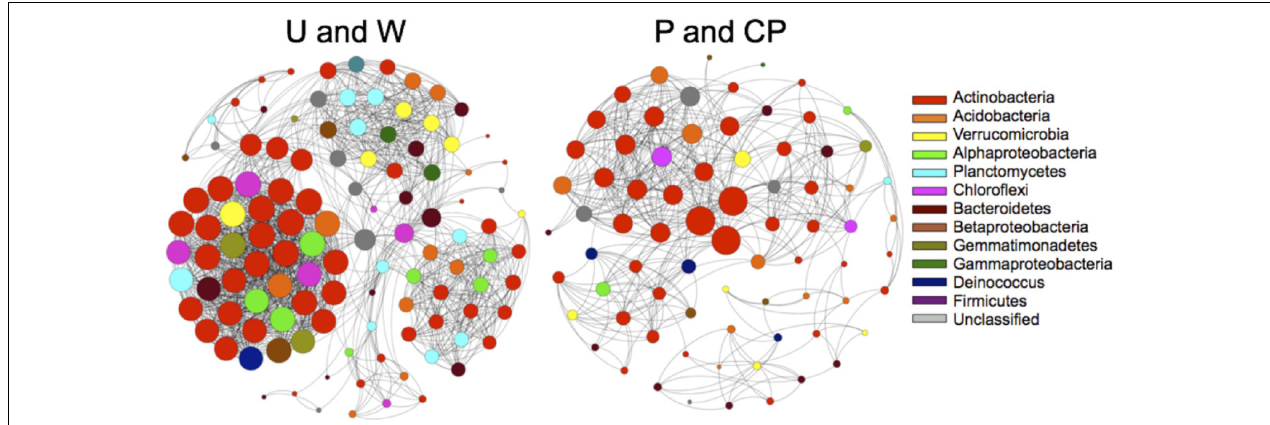
FIGURE 4 | Community interactions among bacterial species deteriorated with the addition of P and CP. The two network models are based on OTUs from two 16S rDNA community libraries of Control and W, and P and CP treatments.